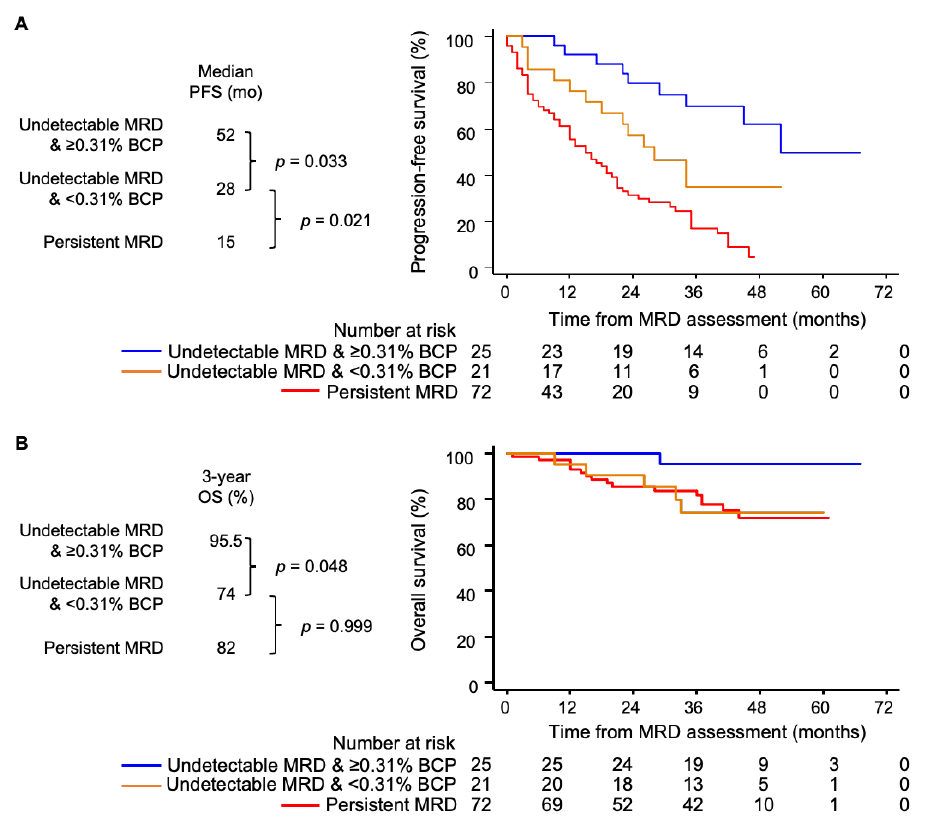
Figure 3. Simultaneous assessment of measurable residual disease (MRD) and hemodilution in bone marrow (BM) aspirates. ( A , B ) Progression-free (PFS) and overall survival (OS) of transplant-ineligible multiple myeloma patients ( n = 118) enrolled in the PETHEMA/GEM2010MAS65 clinical trial, stratified according to detectable vs. undetectable MRD at the end of treatment and, within the latter, according to the percentage of BM B-cell precursors (BCP) below or above the median value observed in healthy adults older than 65 (0.31%, Table